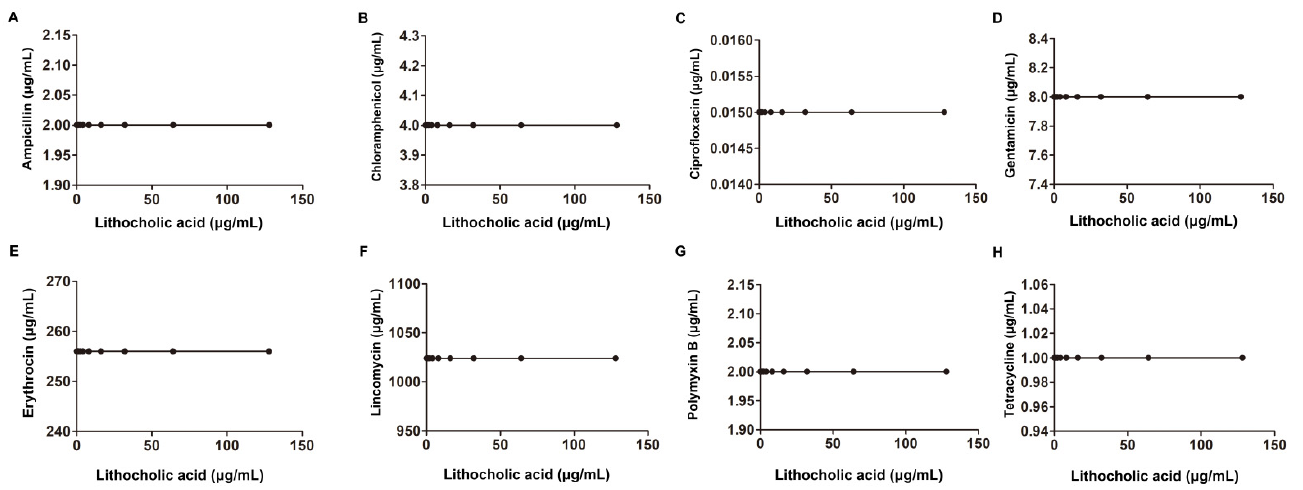
Figure 6. Interaction of LCA with Amp, Ery, Genta, Cip, Lin, Tet, Cpl and Pmb against Acinetobacter baumannii ATCC19606 ( A – H ).